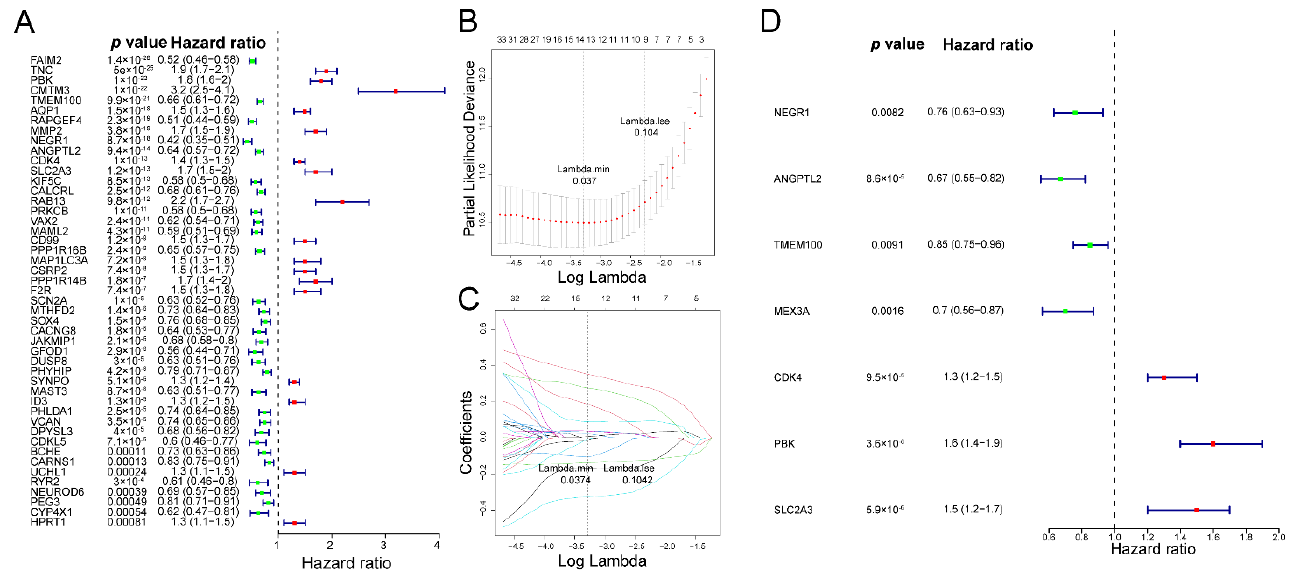
Figure 2. Identification of fibroblast-related prognostic genes: ( A ) forest map of univariate Cox regression analysis; ( B , C ) lasso logistic regression coefficient penalty diagram; and ( D ) forest map of multivariate Cox regression analysis.